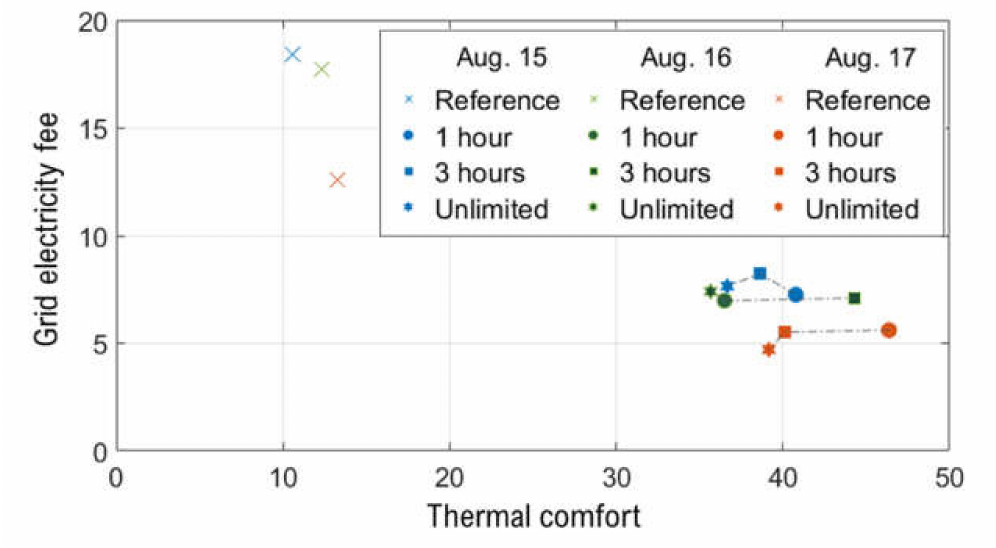
Figure 6. Pareto curve for MPC control in a commercial